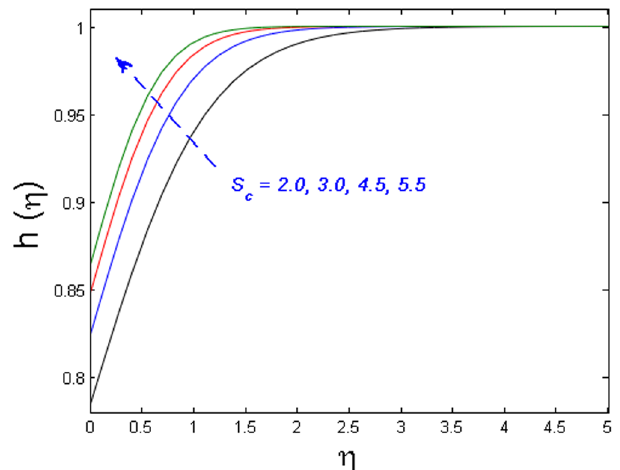
Figure 20. Effect of S c on h ( η